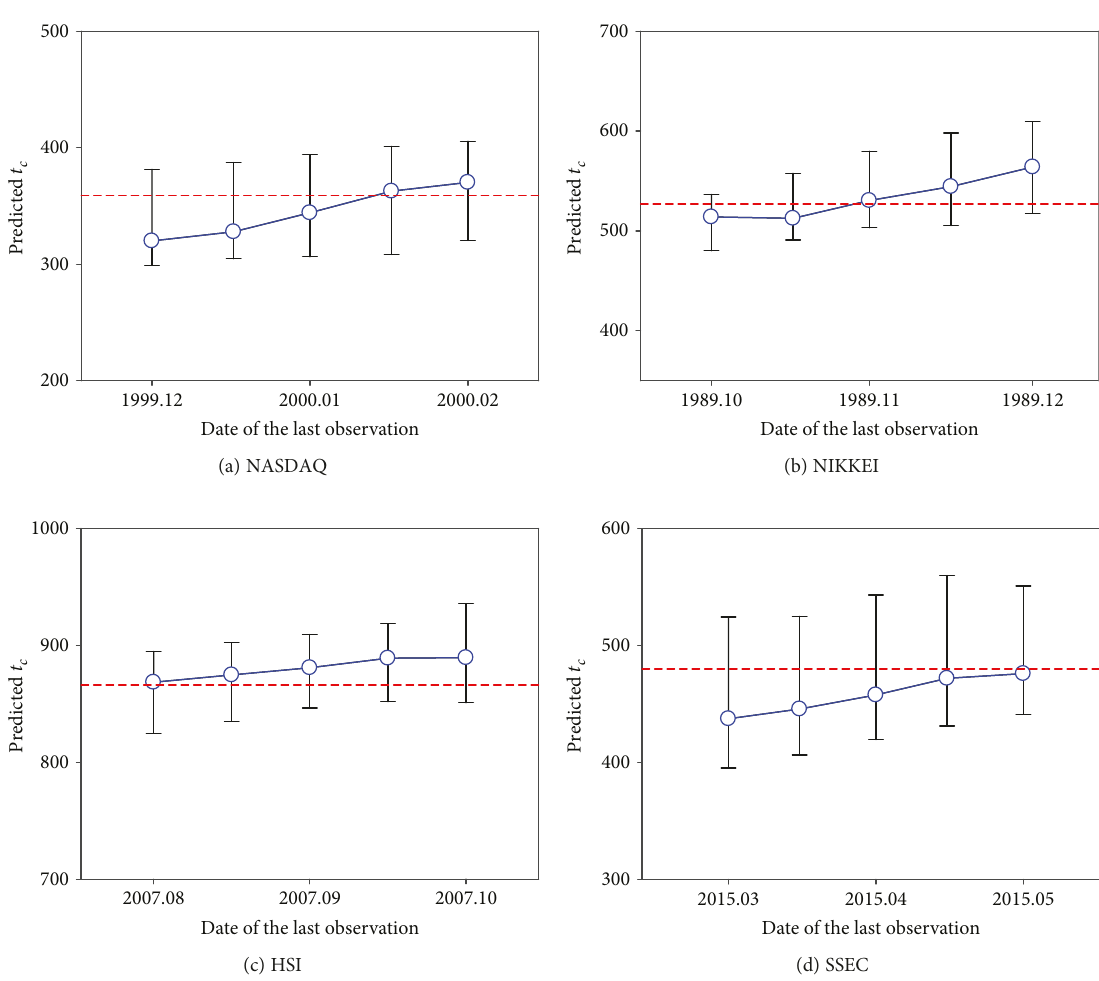
Figure 3: Crash lock-in plots with rolling estimation